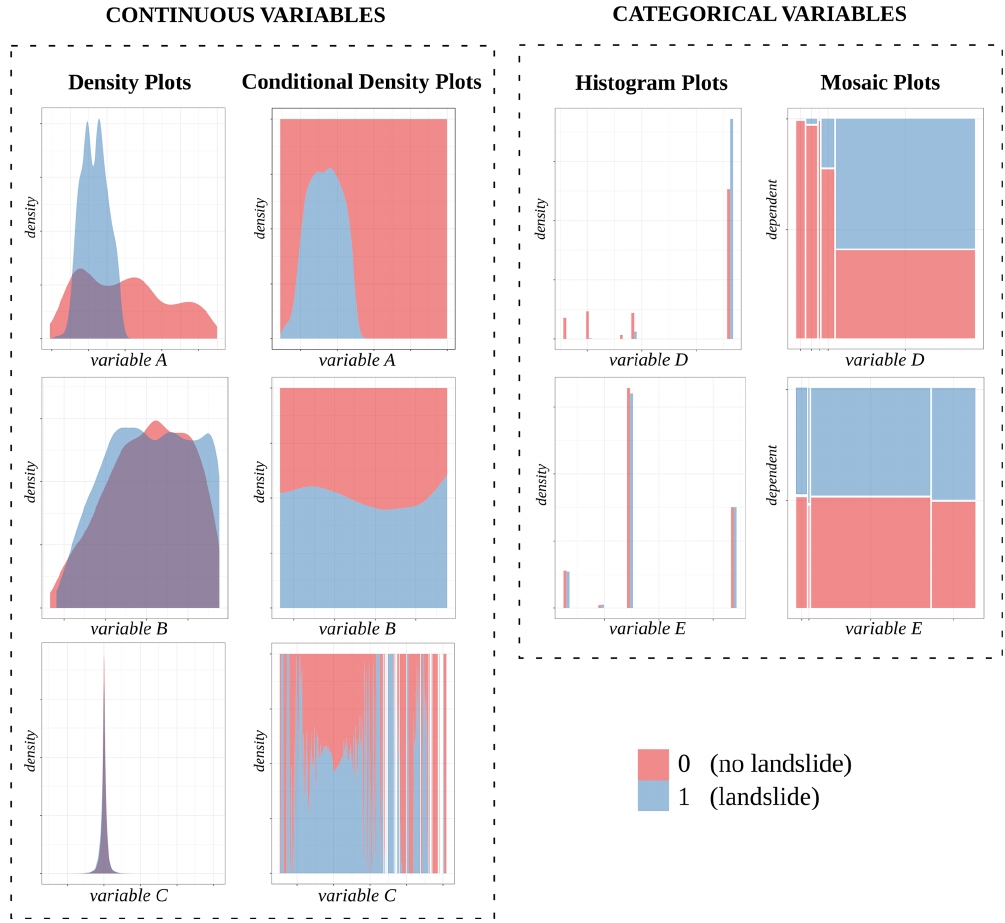
Figure 3. Example of the conditional density analysis outputs generated by LAND-SVA for five synthetic explanatory